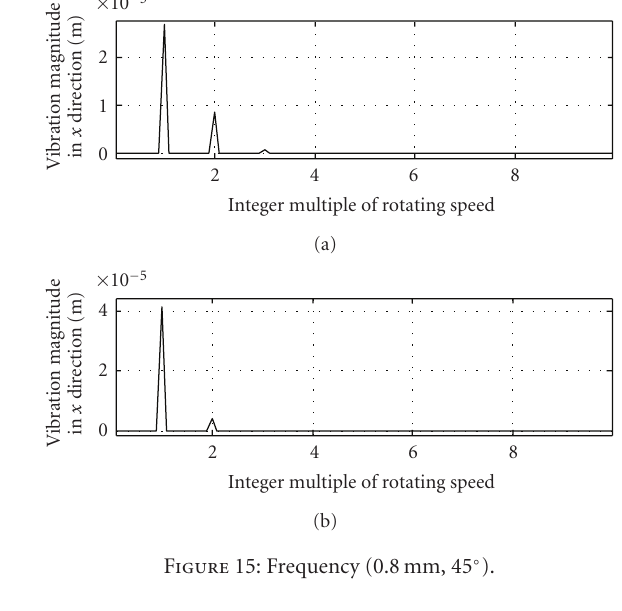
Figure 15: Frequency (0.8mm, 45 ◦ ).